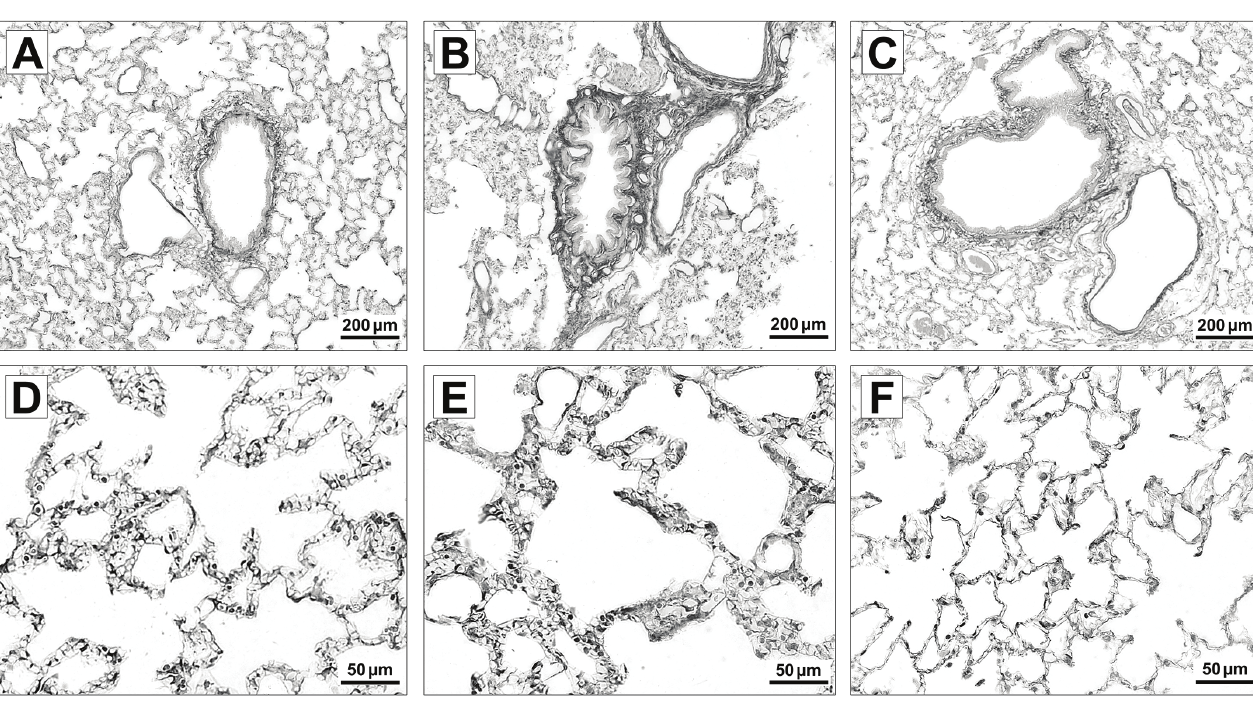
FIGURE 6 - Histology of lung tissue stained by picrusirius red. Control group (A, D), Diabetes Mellitus group (B, E) and Diabetic Cissampelos sympodialis treatment group (C, F). Magnification 100X (A, B, C) and 400 X (D, E, F).